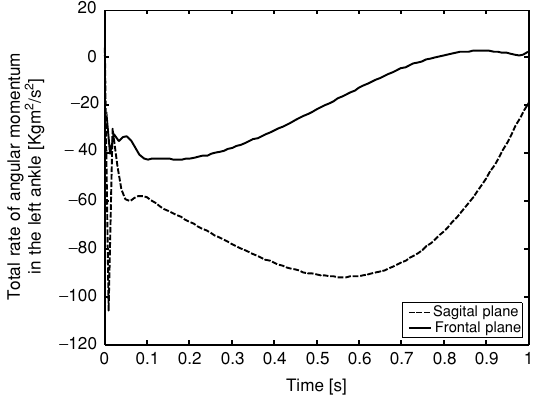
δ = 0 to keep the P